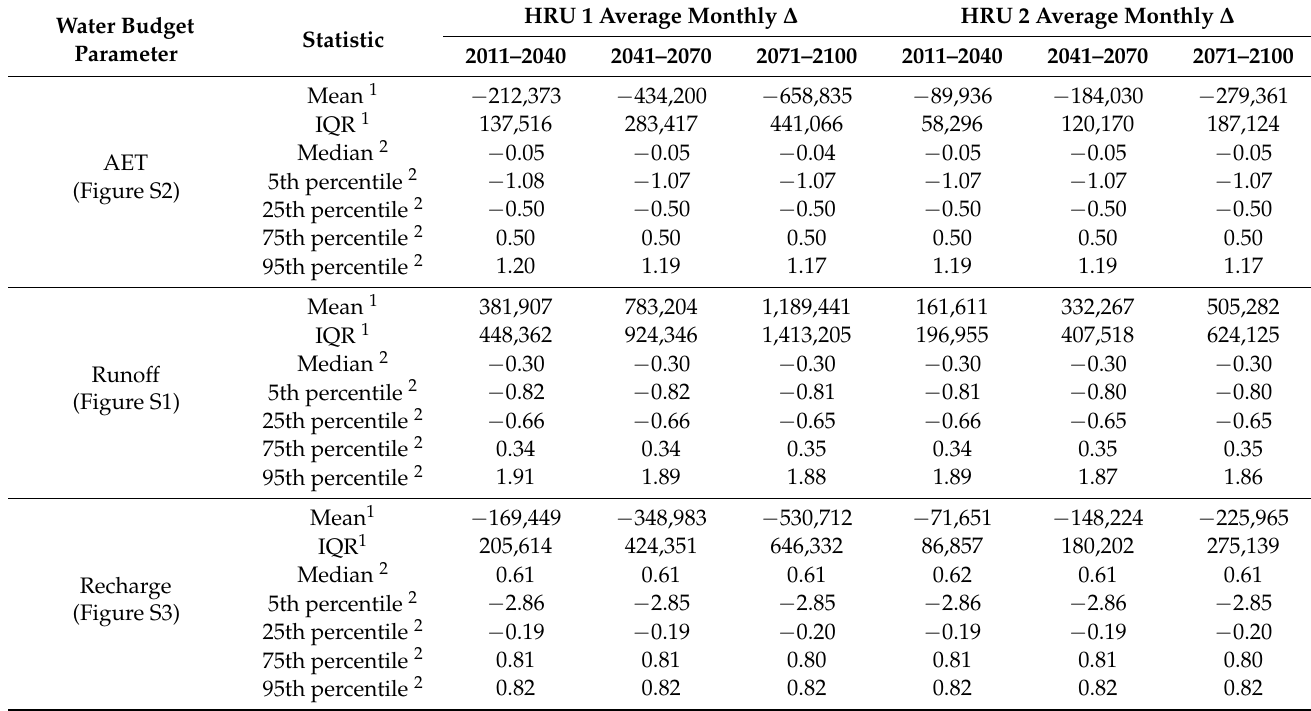
Table 6. LULCCC Scenario Water Budget Component Results for HRU 1 and 2.